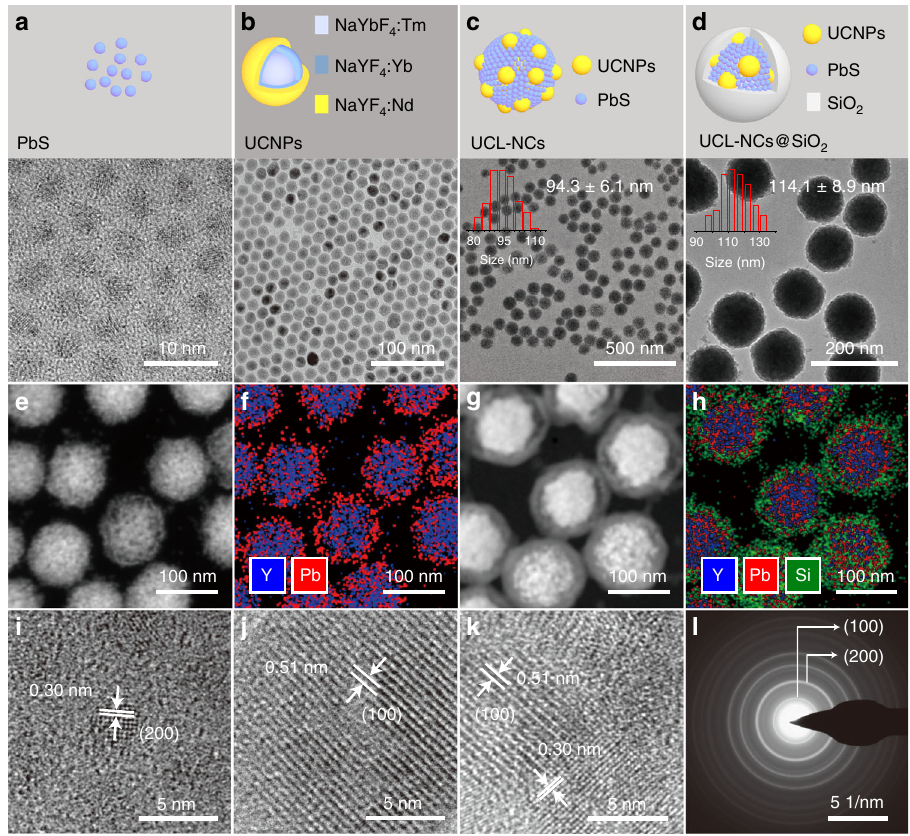
Fig. 2 Characterization of UCL-NCs. TEM images of a PbS QDs, b core-shell-shell Nd sensitized Tm-UCNPs, c UCL-NCs and d mPEG-silane functionalized silica-coated UCL-NCs. Images of dark- fi eld scanning TEM and corresponding EDS elemental mapping of ( e , f ) UCL-NCs and ( g , h ) UCL-NCs@SiO 2 . HR- TEM images of ( i ) PbS QDs, ( j ) core-shell-shell Nd sensitized Tm-UCNPs and ( k) UCL-NCs. l Electron diffraction image of